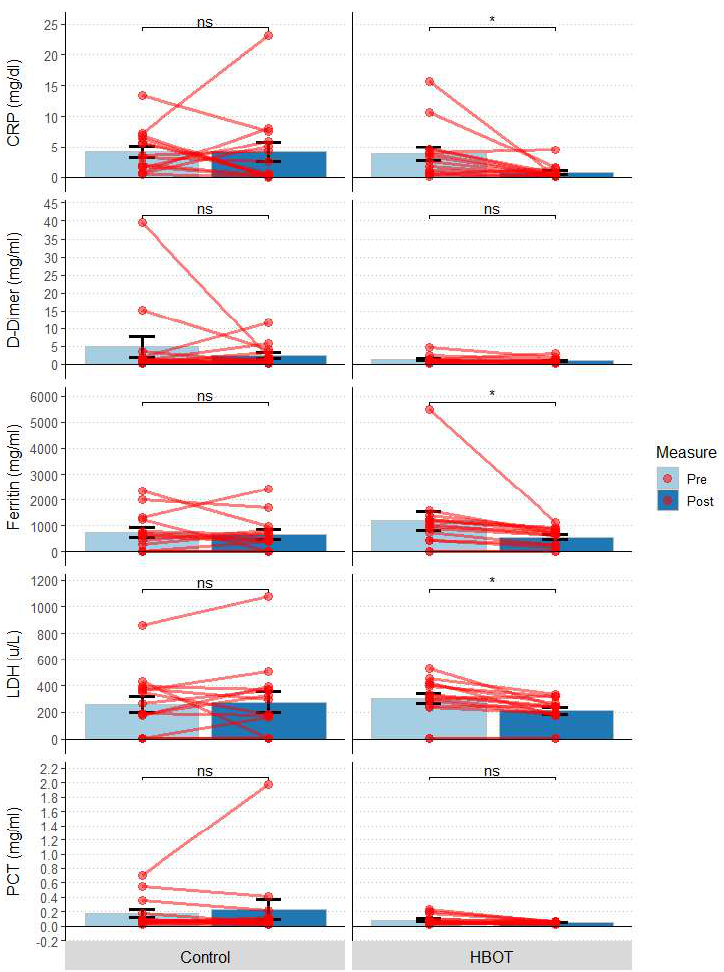
Figure 4. Biochemical parameters at the first measurement (Pre) and 10 days after study initiation (Post); bars represent mean, error bars represent standard error, red lines represent individual patient results: * p < 0.05, ns p > 0.05; HBOT n = 14, Control n =